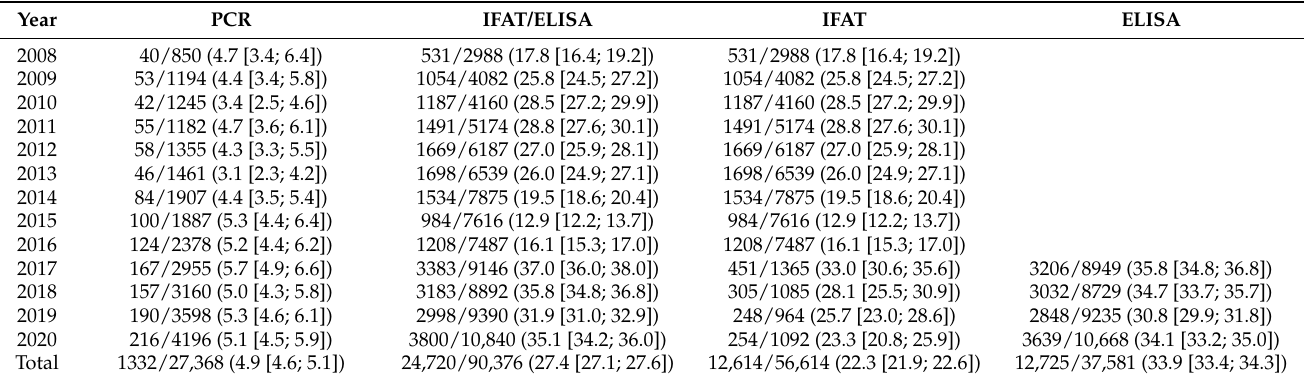
The year of sample collection had a statistically significant impact on the results of both PCR and antibody testing (PCR: χ 2 = 25.264, df = 12, p = 0.014, ϕ = 0.030; antibody testing: χ 2 = 2845.303, df = 12, p < 0.001, ϕ = 0.177), as did the time of year (by month) a sample was taken (PCR: χ 2 = 775.053, df = 11, p < 0.001, ϕ = 0.168; antibody testing: χ 2 = 730.484, df = 11, p < 0.001, ϕ = 0.090) (Table 2). Table 2. Number of positive tests in dogs including direct and indirect detection methods for Anaplasma phagocytophilum in dogs living in Germany from 2008–2020 sorted by years of testing ( n positive/ N total (% [95% CI lower limit; 95% CI upper limit]).